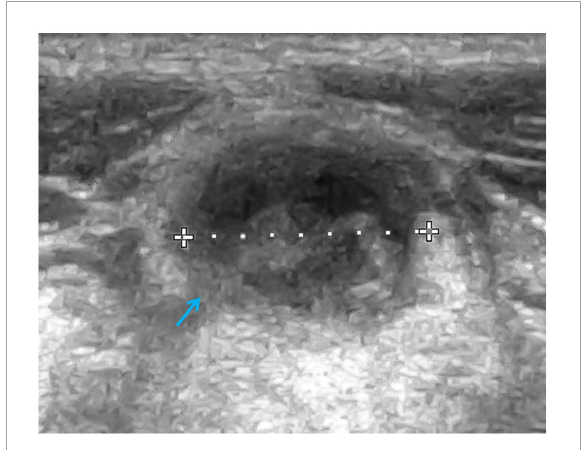
FIGURE1 Ultrasound (US) examination of the lymph node, linear probe. A cervical lymph node with an abnormal echostructure, heterogeneous hypoechogenicity, and change of a shape from oval to round (marked with an